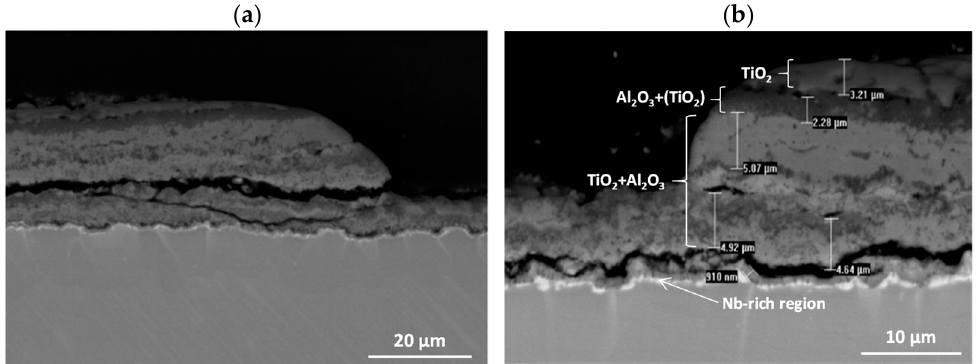
Figure 19. SEM-BSE images of Ti–46Al–7Nb–0.7Cr–0.1Si–0.2Ni alloy after cyclic oxidation at 975 °C (surface prepared by grinding): ( a ) low-magnification, ( b ) high-magnification.